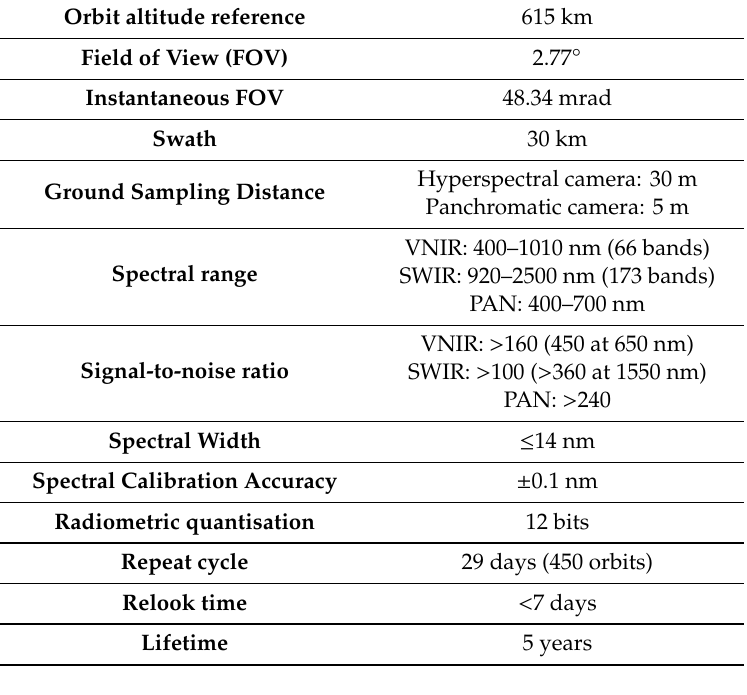
Table 1. Main features of the PRISMA